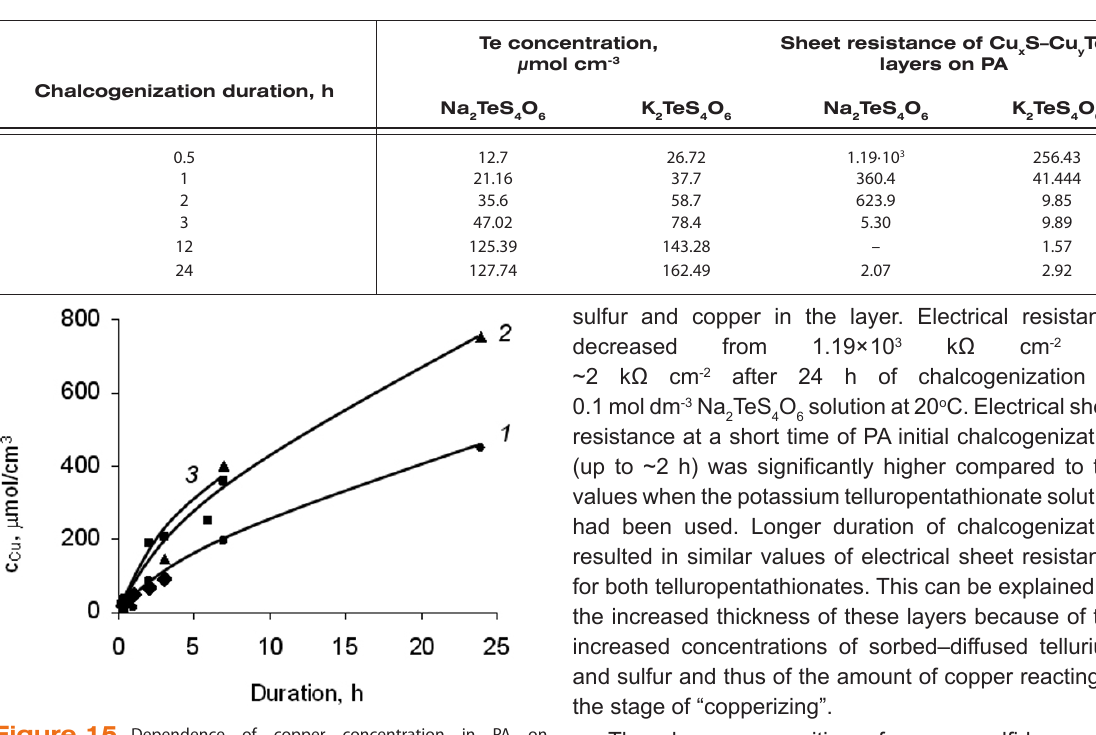
chalcogenization duration when treating it with Na TeS O solution at 20 o C and then in Cu(II/I) salt 2 4 6 solution. The concentration of Na dm -3 : 1 – 0.01; 2 – 0.025; 3 –